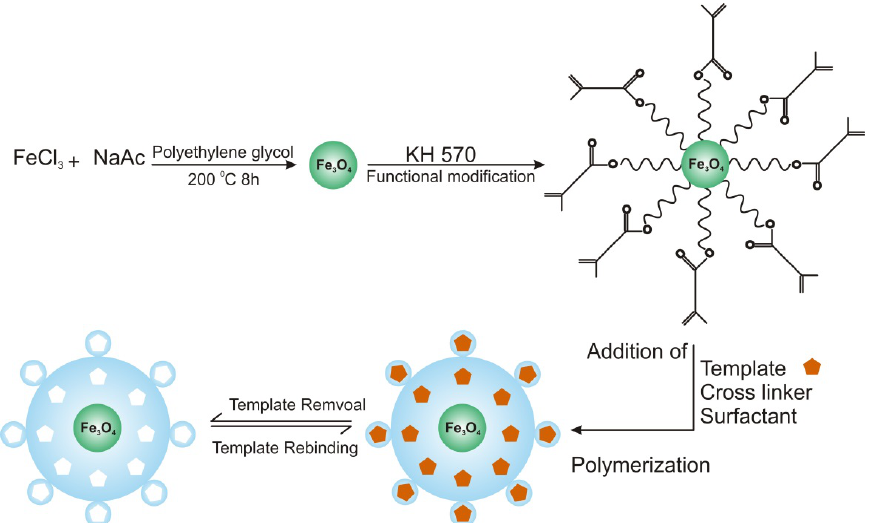
Figure 2. Schematic representation of synthetic route for magnetic imprinted nanoparticles (Imp-NPs). Adopted from